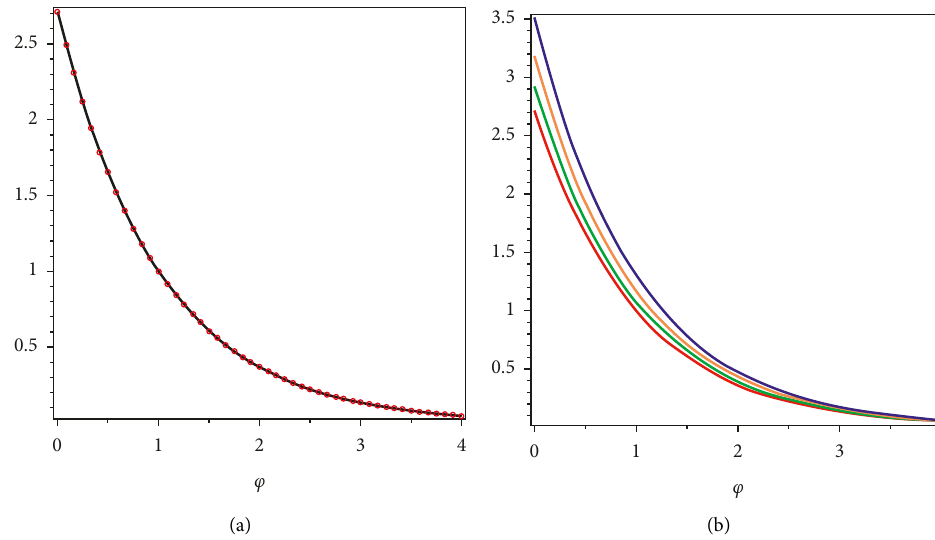
Figure 11: (a) The exact and approximate solution at δ � 1 and (b) the different fractional order of δ